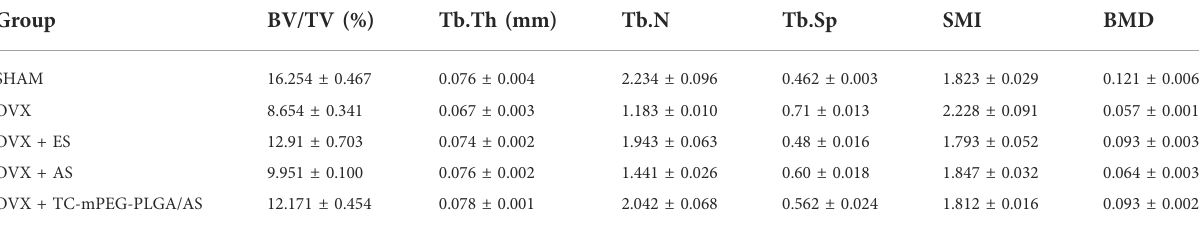
TABLE 3 Morphological parameters of the femur of rats in each group after being ovariectomized ( n = 3). Group